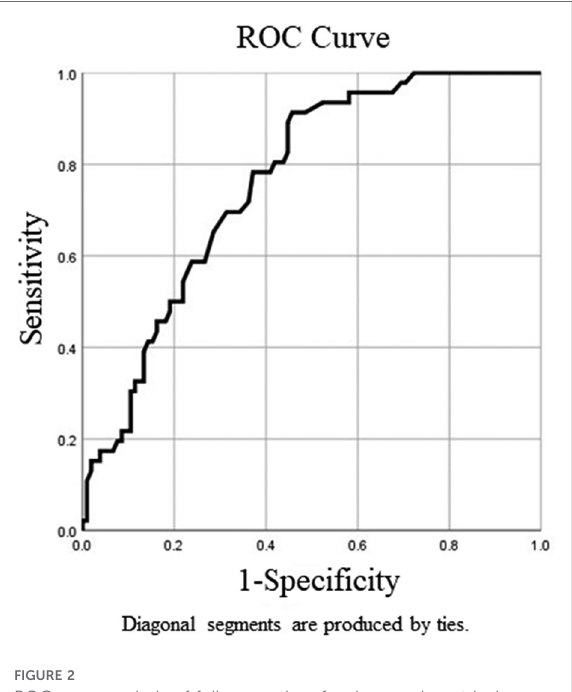
FIGURE 2 ROC curve analysis of follow-up time for deep